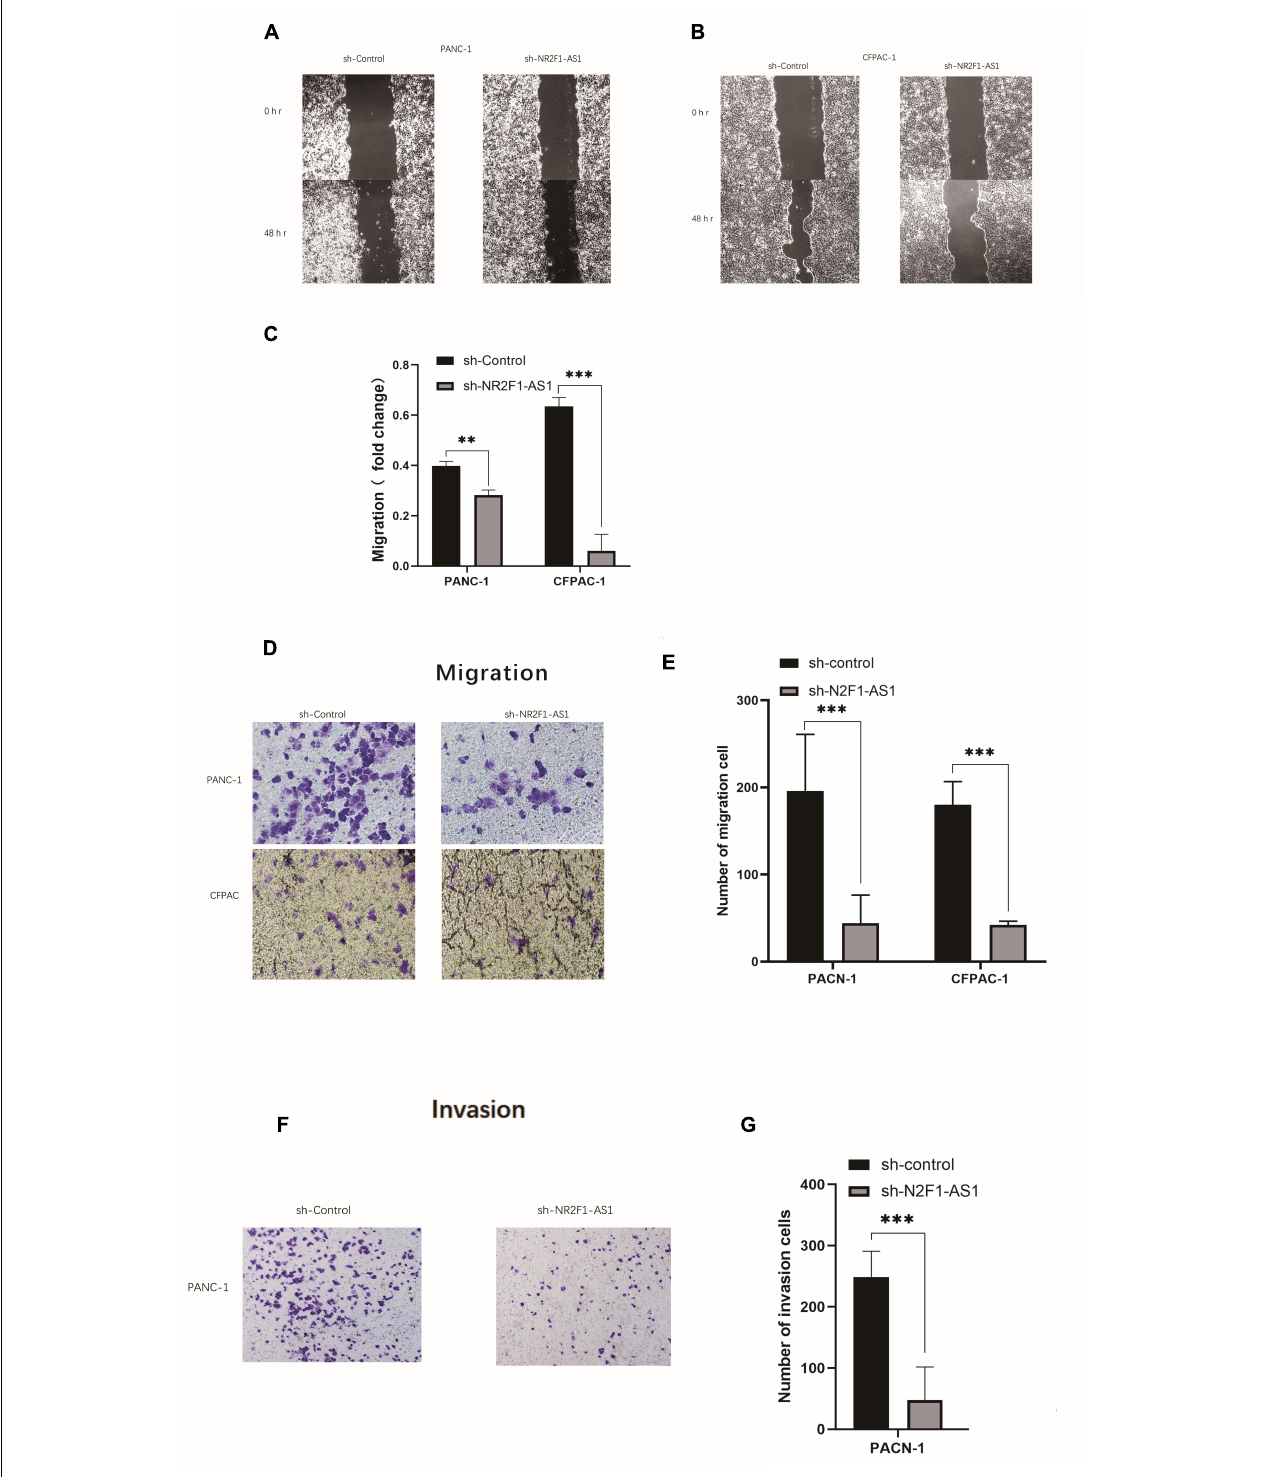
FIGURE 3 | Knockout of NR2F1-AS1 abrogates migration and invasion ability in PDAC. The migration and invasion abilities of tumor cells were assessed using wound healing assays as well as Transwell migration and invasion assays. (A,B) Wound healing assays (photographed after 0 and 48 h). (C) Histograms showing the change in healing area. (D) Transwell migration assays (photographed after 24 h). (E) Histograms showing the numbers of cells that migrated after 24 h. (F) Transwell invasion assays (photographed after 24 h). (G) Histograms showing the numbers of cells that invaded after 24 h. Statistical significance: ** p < 0.01 and *** p < 0.001.